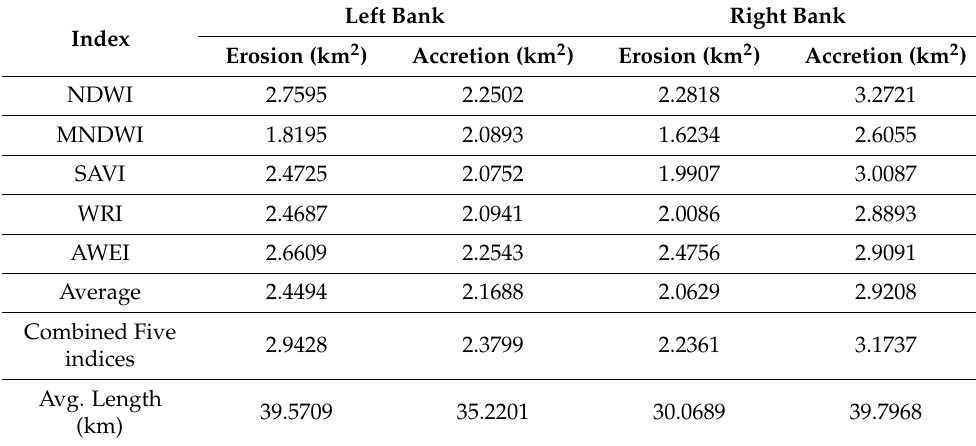
Table 6. Erosion and accretion occurring in the left and right